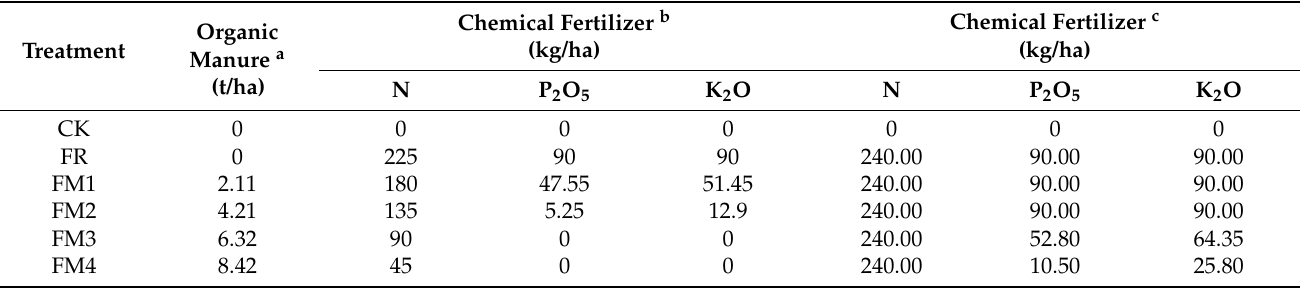
Table 2. Composition of various